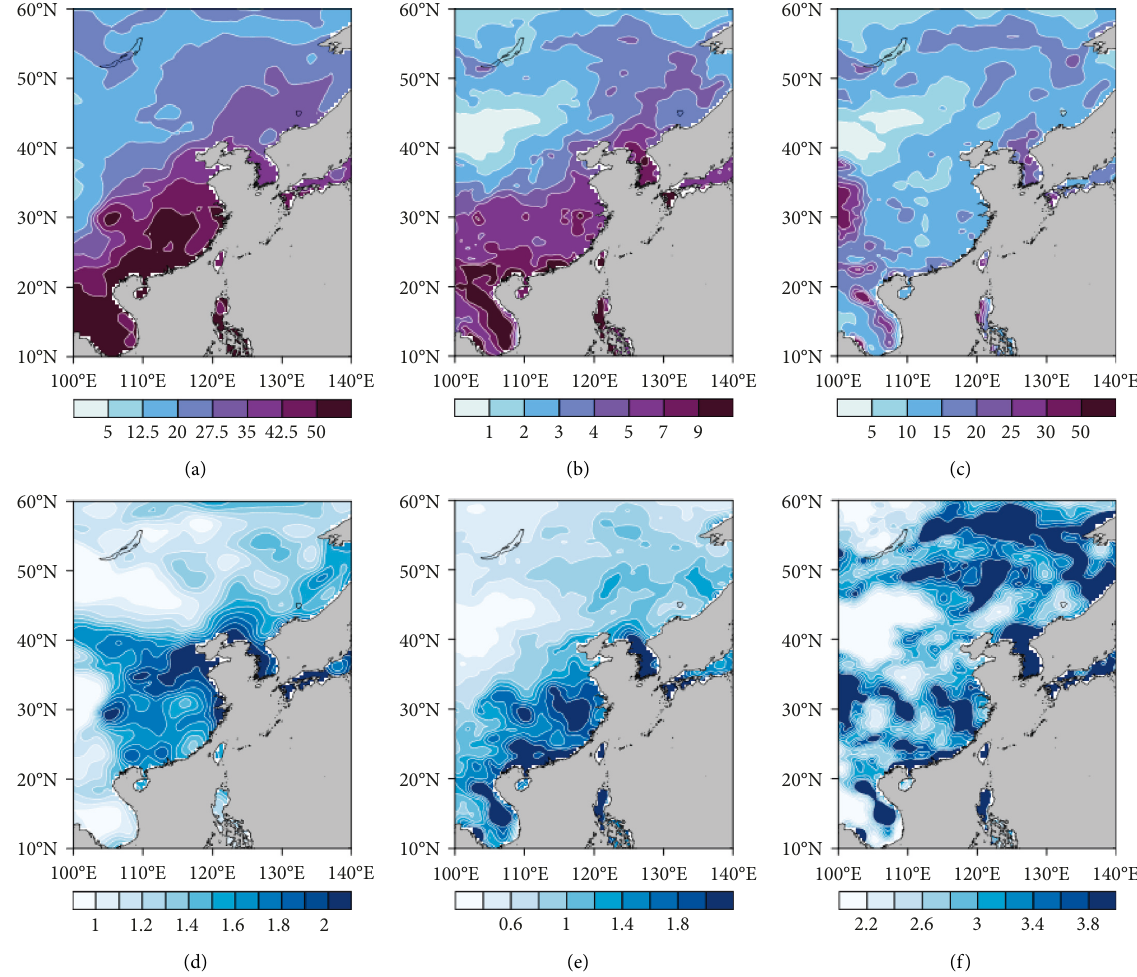
Figure 1: Spatial distributions of (a) mean total precipitable water (mm/d), (b) mean precipitation (mm/d), (c) mean precipitation efficiency (%), and the standard deviations of (d) total precipitable water, (e) precipitation, and (f) precipitation efficiency in boreal summer during